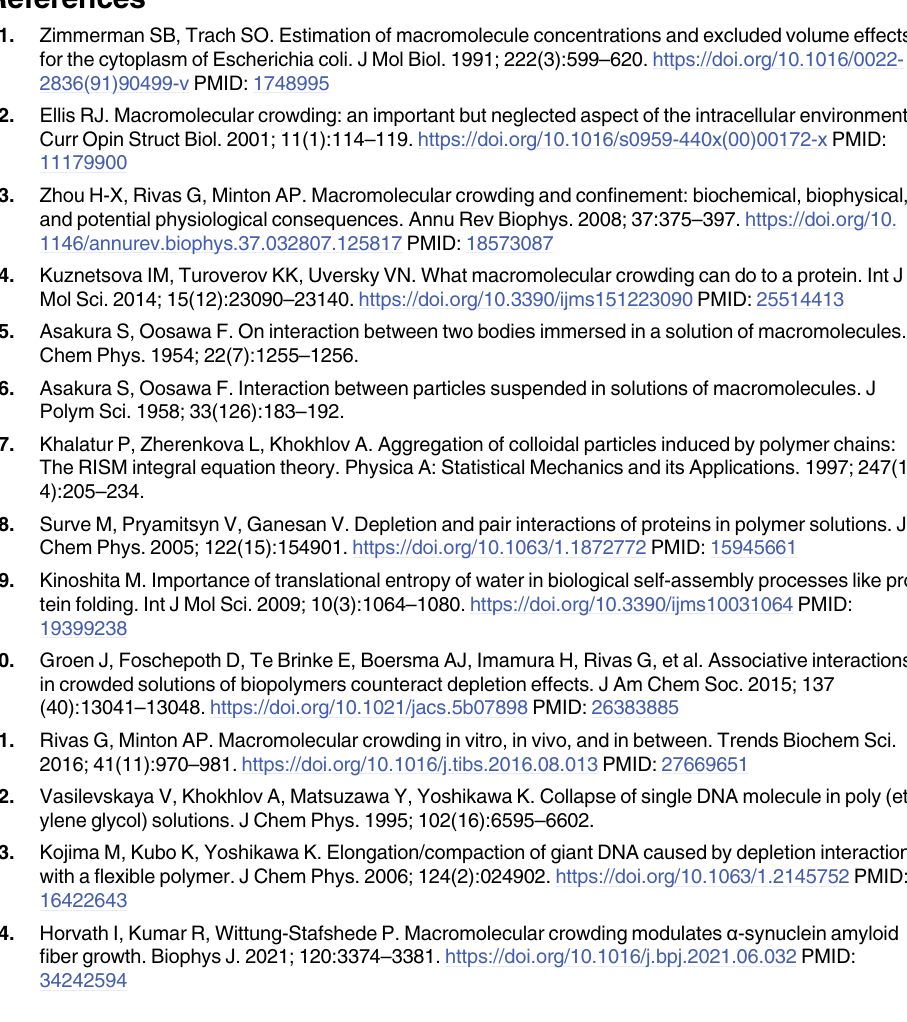
of T4 GT7 DNA molecules from an H